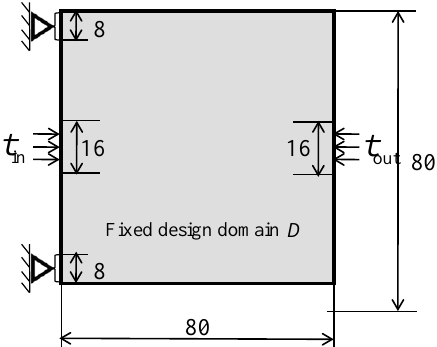
Figure 4. Fixed design domain and boundary conditions of model